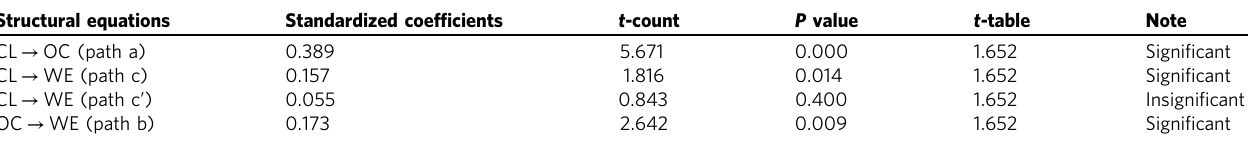
Table 5 Direct in fl uence testing results.